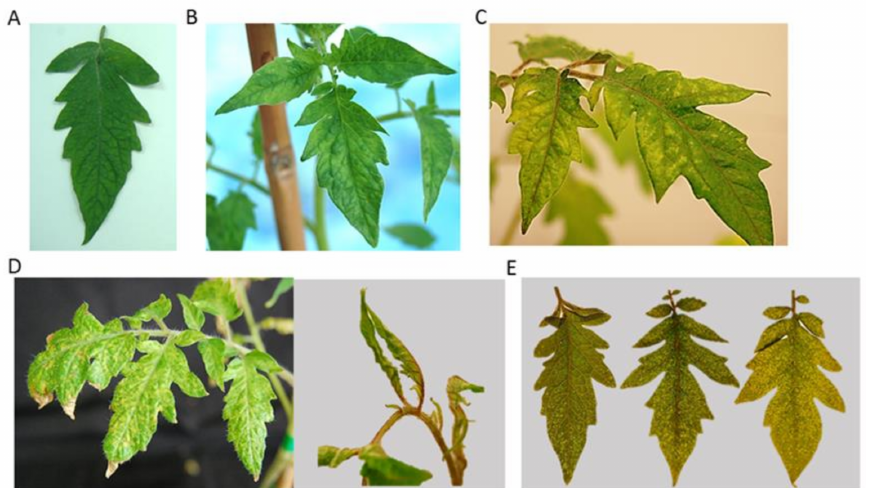
Figure 1. Mosaic and deformation leaf symptoms showed by tomato plants infected with Southern tomato, Pepino mosaic, and Cucumber mosaic viruses (STV, PepMV, and CMV, respectively) in single and mixed infections. Symptoms were considered as mild, moderate or severe (Panels B , C , and D , respectively). The right part of (Panel D ) shows a strong leaf deformation in the plant shoots in tomato plants with severe symptoms. Panel A shows a symptomless leaf corresponding to a mock-inoculated tomato plant. (Panel E ) shows three tomato leaves showing mild, moderate, or severe symptoms (from left to the